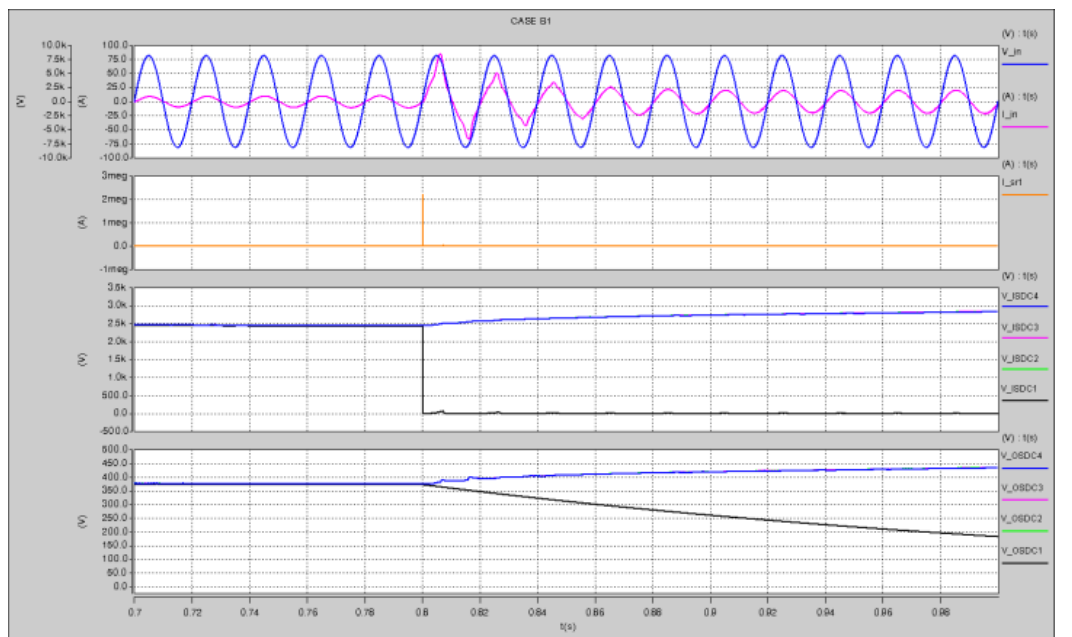
Figure 14. Simulation results of fault